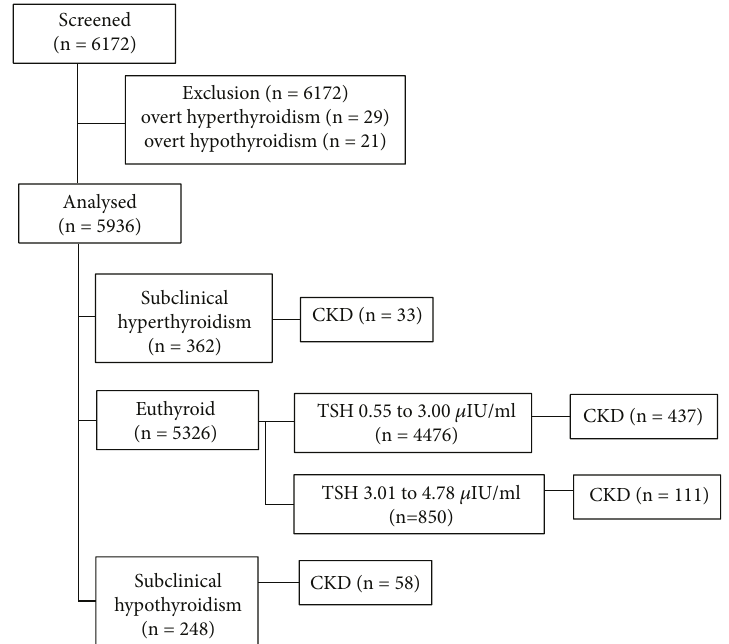
Figure 1: Flow chart of the study participant. CKD (chronic kidney disease) is de fi ned as having an eGFR < 60 ml/min/1.73m 2 .